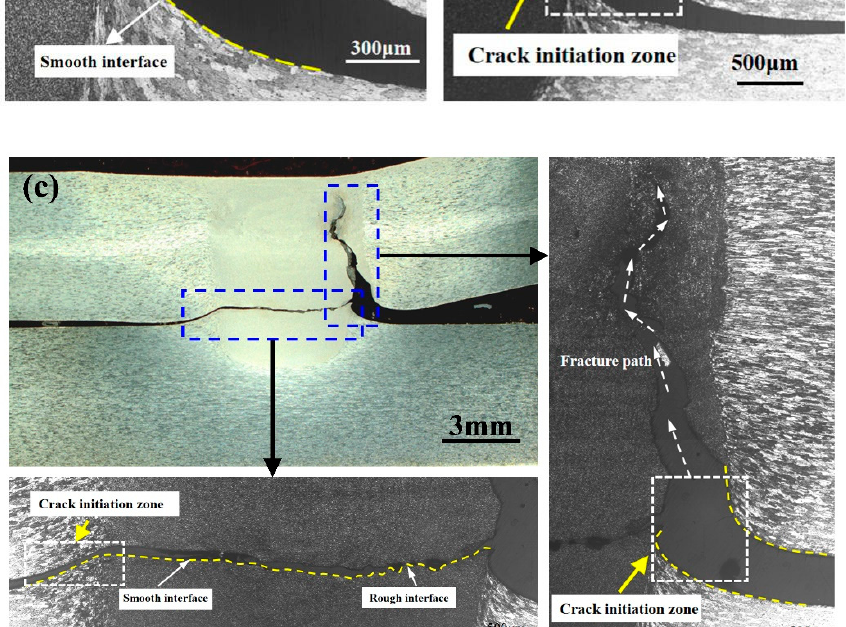
Figure 13. Fracture modes of FSLW joints: ( a ) fracture mode I, ( b ) fracture mode II, and ( c ) fracture mode III.